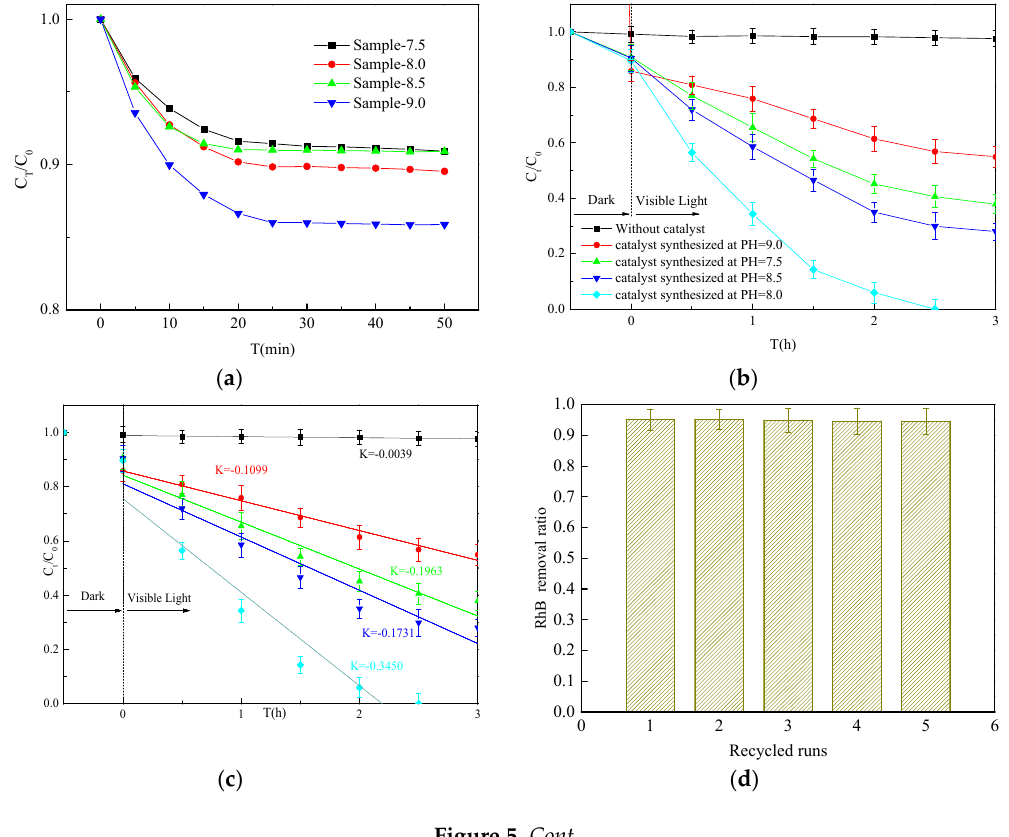
Sample-7.5 Sample-8.0 Sample-8.5